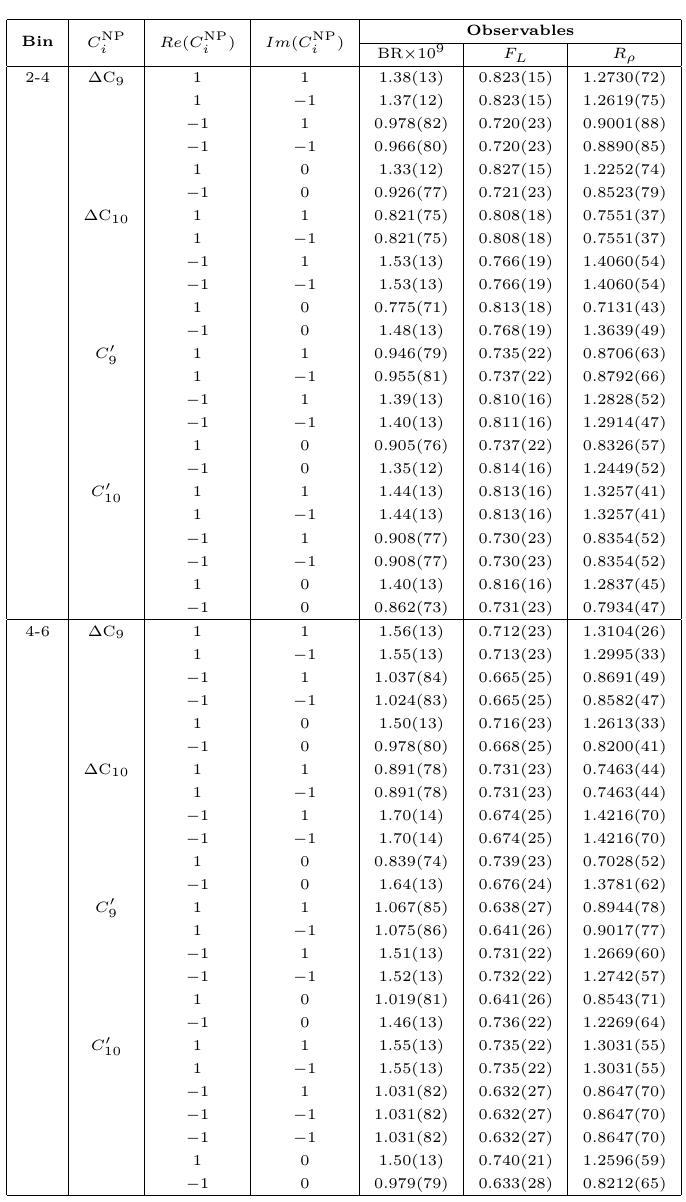
Table 41 . The dependence of the Branching Ratio and the observables F L and R ρ corresponding to ¯ B ( B ) → ρ 0 ll on the real and imaginary parts of the NP WC’s ∆ C 9 , 10 and C 0 and 4 − 6 GeV 2 for a few benchmark values of the real and imaginary parts of the corresponding